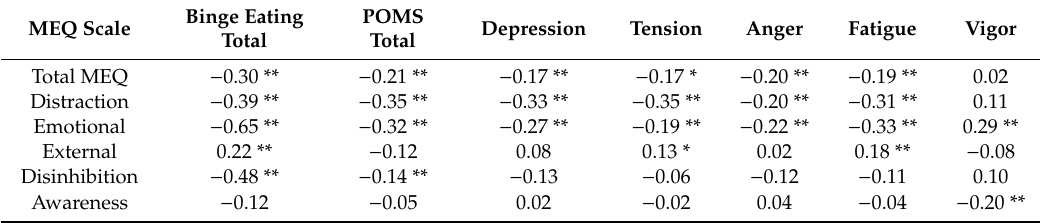
Table 3. Correlations between MEQ, binge eating, and mood state